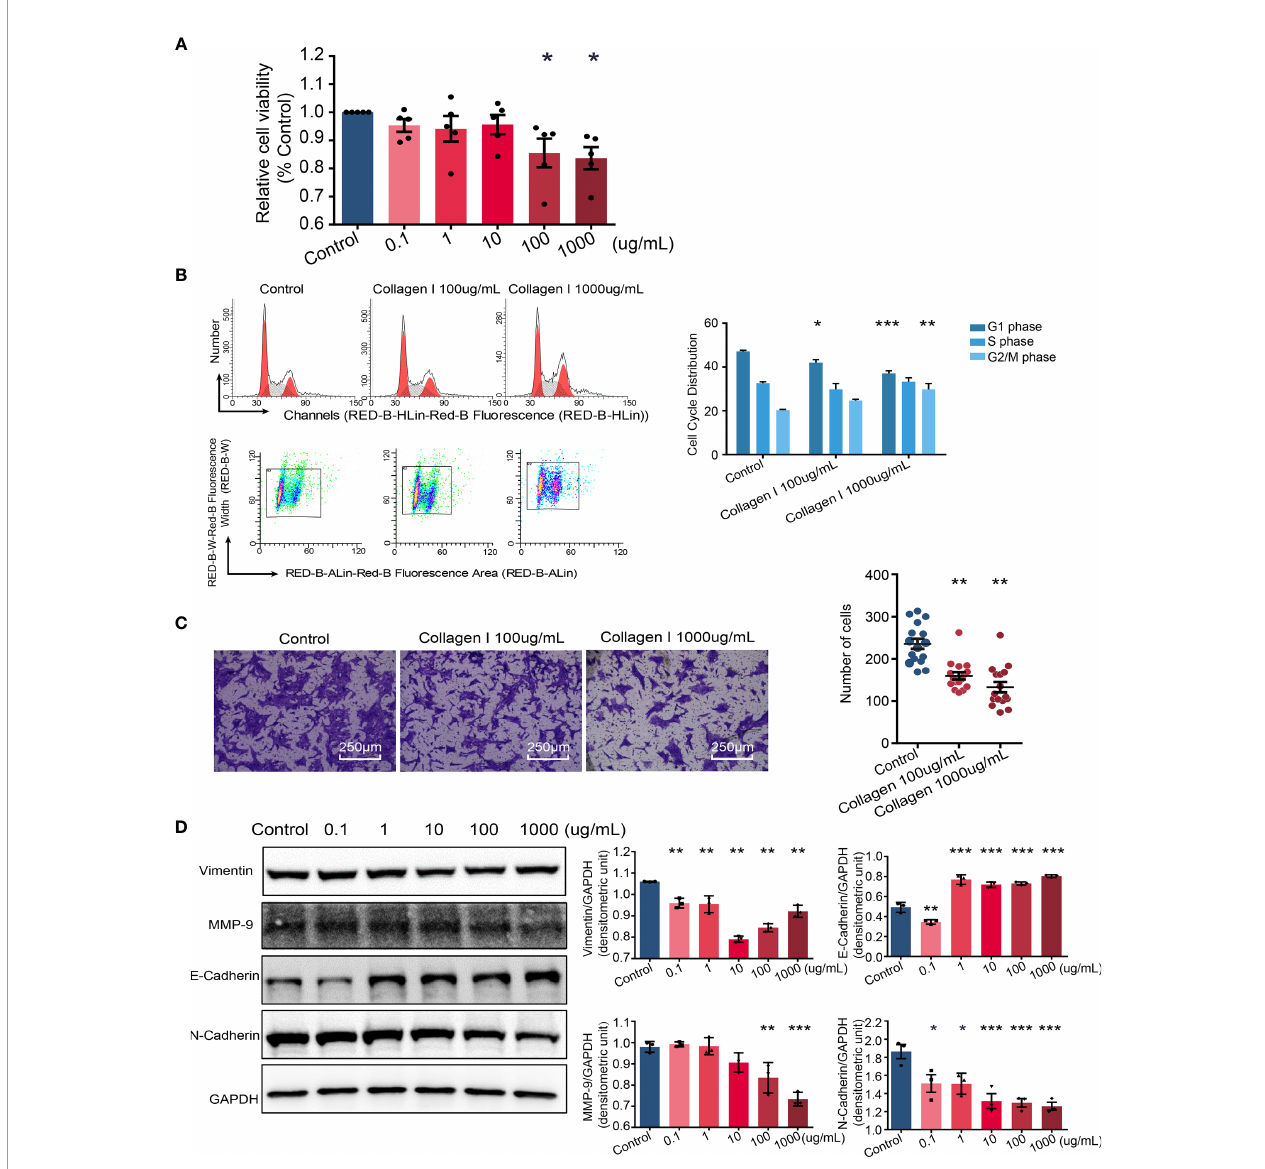
FIGURE 3 | Collagen I induce trophoblast dysfunction in HTR-8/SVneo cells. Effect of collagen I on proliferation and invasion abilities of HTR-8/SVneo cells. (A) HTR-8/SVneo cells were cultured at different concentrations of collagen I (0 m g/mL, 0.1 m g/mL, 1 m g/mL, 10 m g/mL, 100 m g/mL, and 1000 m g/mL). Cell proliferation of HTR-8SV/neo cells was analyzed by CCK-8 assay after 48 hours of incubation (n = 5 per group). (B) Effect of collagen I on the cell cycle pro fi le of HTR-8SV/neo cells. After cultured at 100 m g/mL and 1000 m g/mL of collagen I for 48 hours, cells were labeled with propidium iodide and the stain was detected by laser scanning cytometry(LSC). Bar plot representing the proportion of cells at each phase of the cell cycle (G1, S, and G2/M phases) in three different cell groups (cells grown in presence of 100 m g/mL or 1000 m g/mL of collagen I and control cells; n = 5 per group). (C) Migration of HTR-8/SVneo cells. The total number of invading cells was counted in four representative fi elds under ×200 magni fi cation (n = 4 per group). (D) Representative western blot image and quantitative analysis of vimentin, MMP-9, E-cadherin, and N-cadherin expression in the three cell groups (n = 3 per group). Asterisks indicate differences between groups vs. control, with *p < 0.05, **p < 0.01, and ***p < 0.001, according to one-way ANOVA followed by Dunnett post-hoc